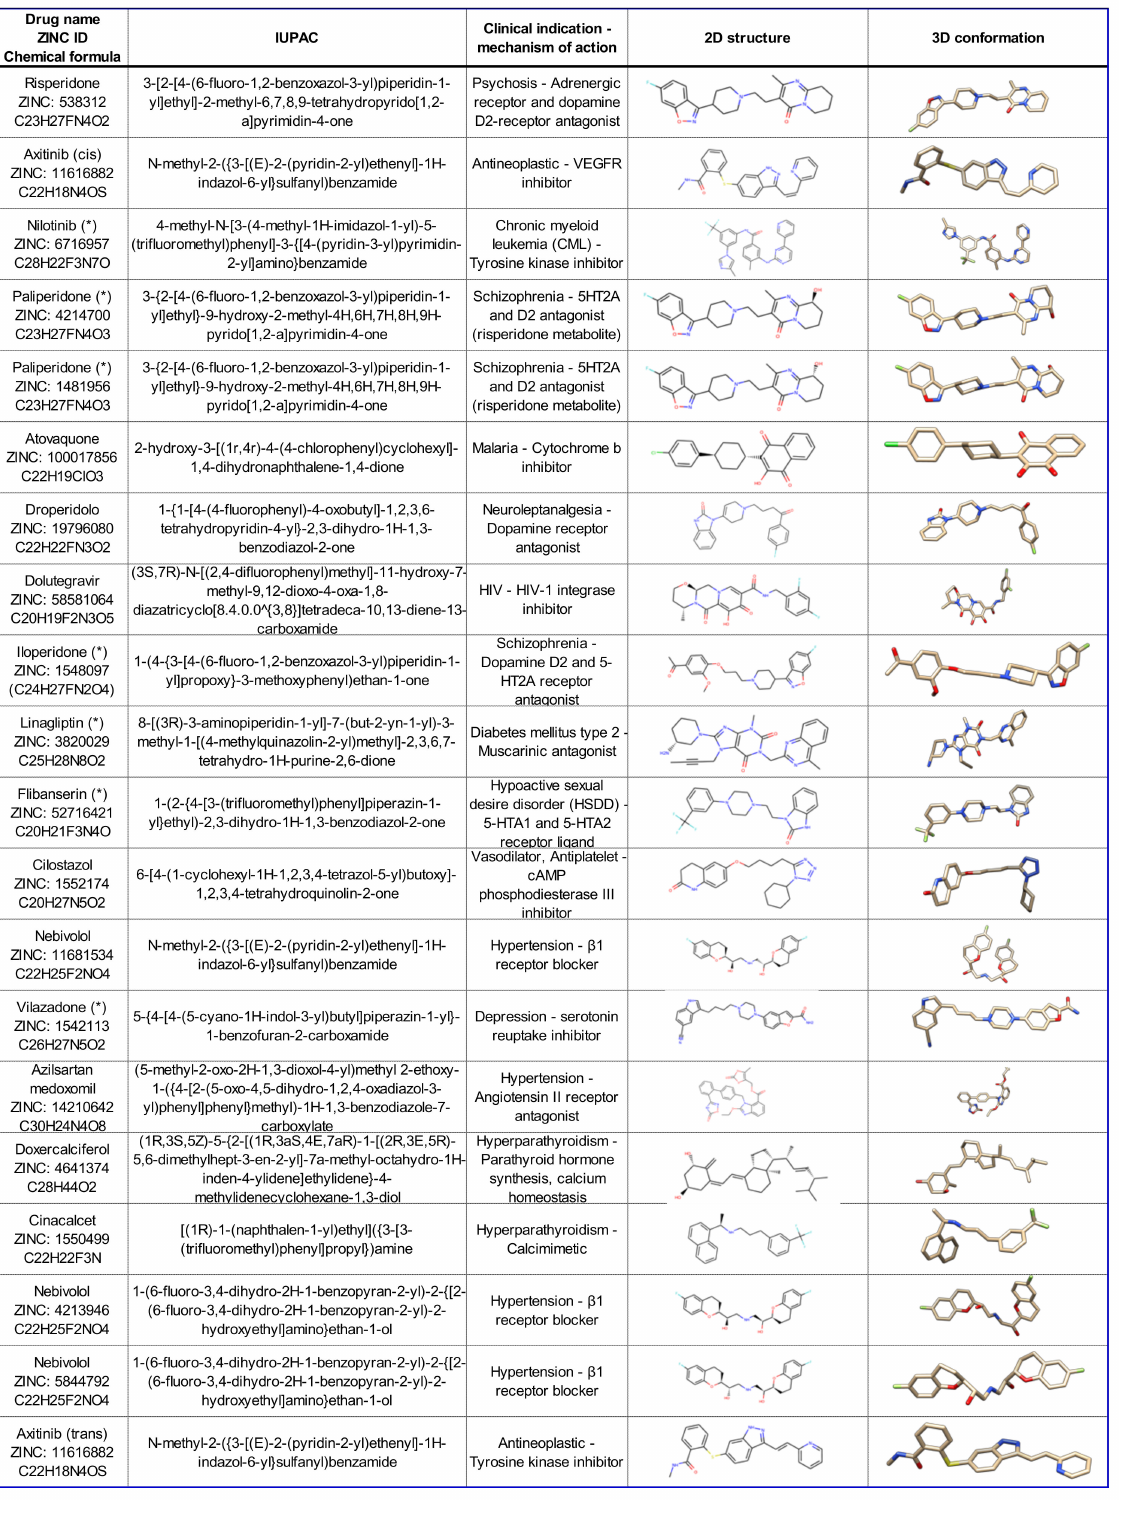
Figure 2. Clinical indication and chemical structures of the compounds listed in Table 2. Compounds selected for experimental validation by SPR are indicated by an asterisk